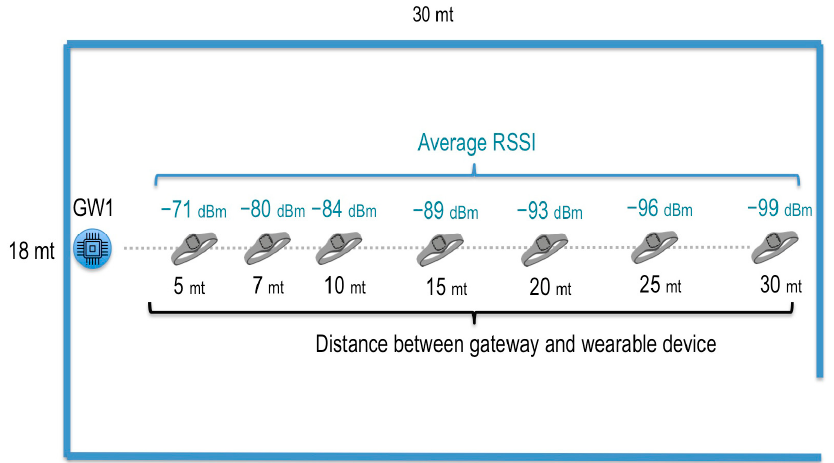
Figure 13. Received Signal Strength Indicator (RSSI) tests on Bluetooth Low Energy (BLE) with single gateway.